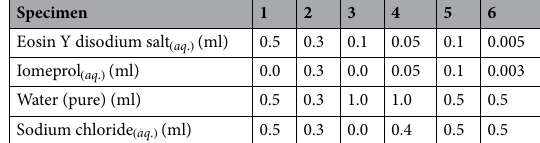
Table 6. Listing of all volumes pipetted into the 1.5ml tubes for each specimen.